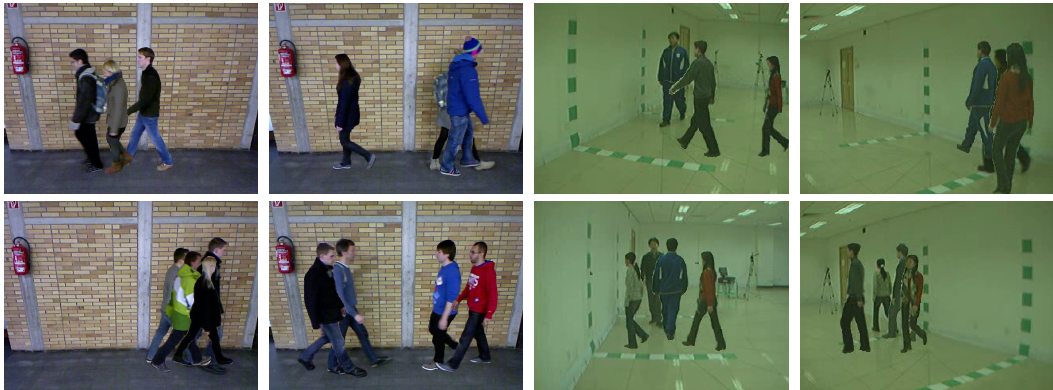
Figure 2. Samples generated with MuPeG. Output frames obtained with subjects from TUM-GAID and CASIA-B datasets under different walking conditions (view-points, carrying conditions,